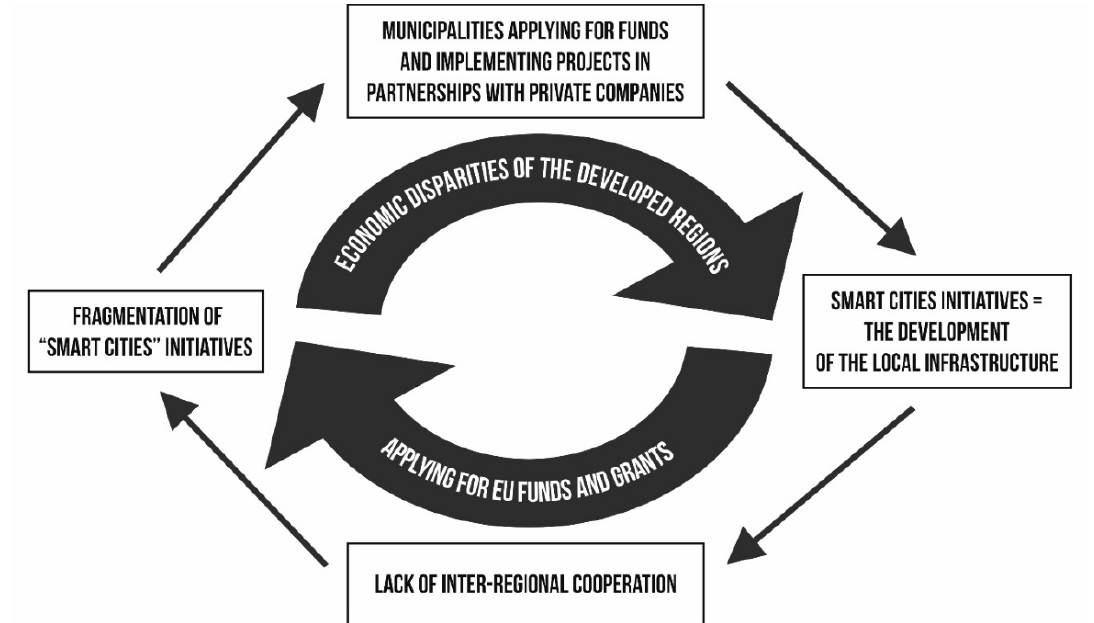
Figure 5. The vicious cycle of the regional disparities and transnational funding of the smart city projects.